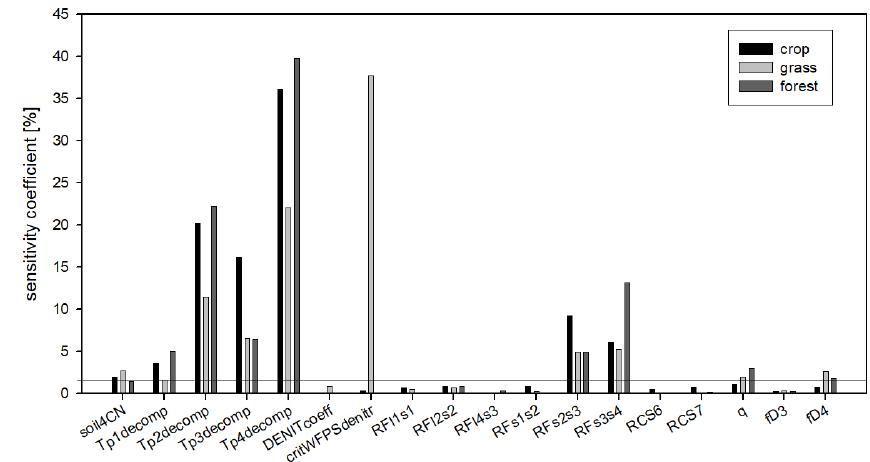
Figure 14. The sensitivity coefficients of the soil parameters as the result of the sensitivity analysis. Black columns refer to the crop, light grey to the grass, and dark grey to the forest simulations. The sensitivity coefficients are calculated as the mean pixel-level sensitivity coefficient for the given land use type. The horizontal line indicates the 5% threshold that was used to select the final parameter set for optimization.